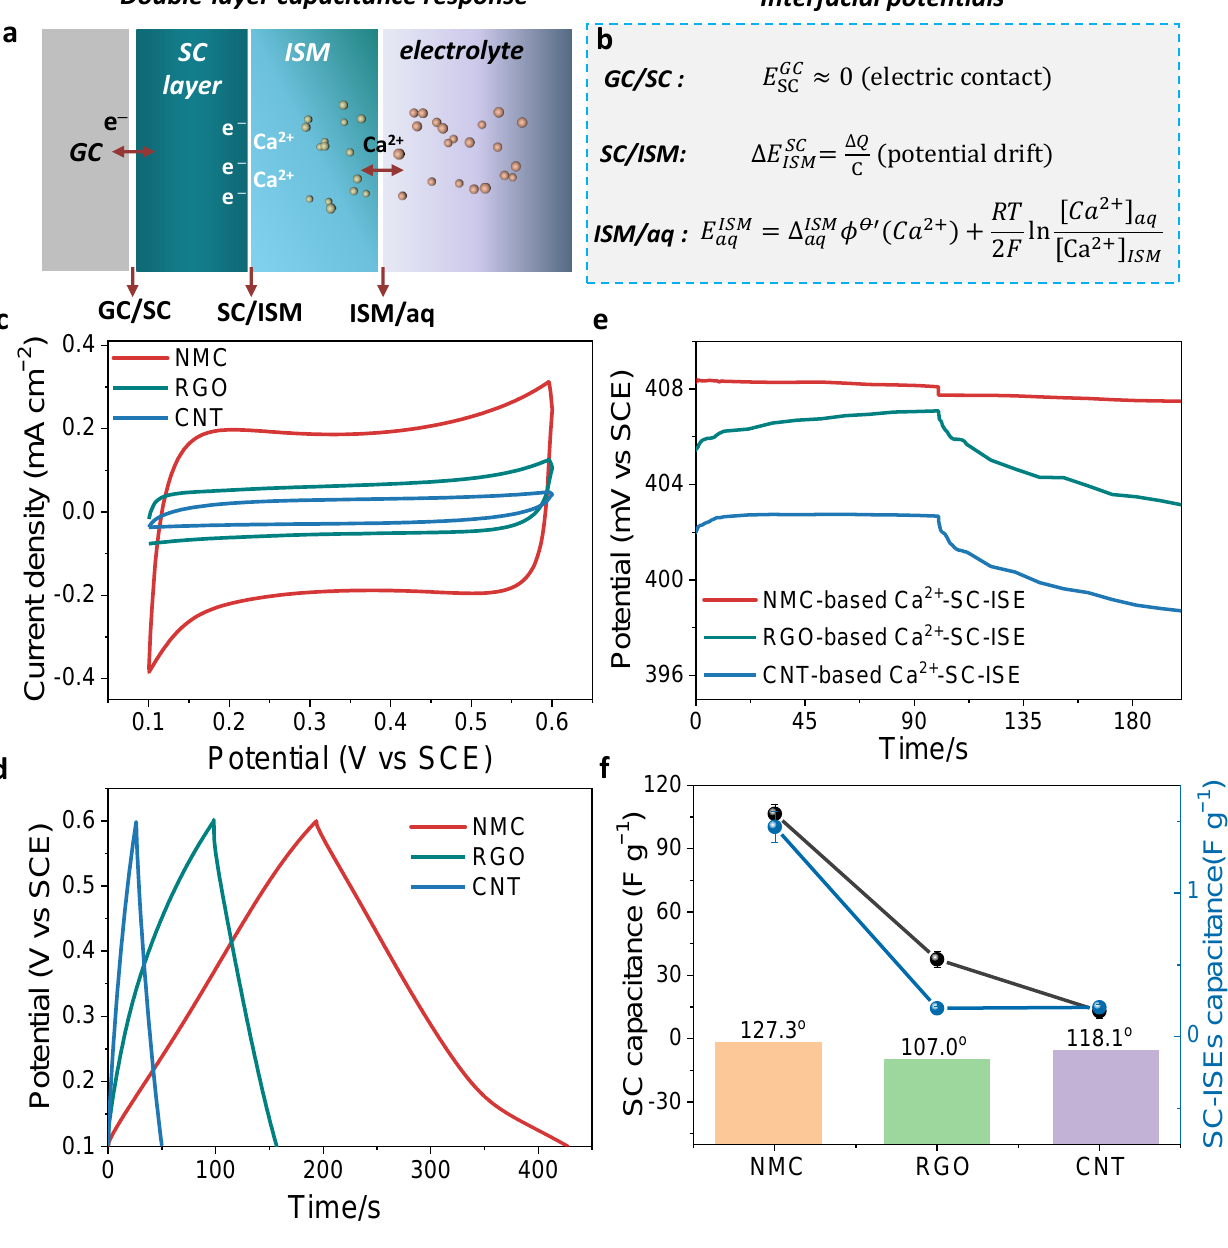
Figure 3. Capacitance evaluation. ( a ) Electric-double-layer (EDL) capacitance-based SC-ISEs which contain three phase boundaries including GC/SC, SC/ISM, and ISM/aq interfaces and ( b ) the corresponding phase interfacial potentials. ( c ) Cyclic voltammetry curves for SC materials (NMC, RGO, CNT) in 0.1 M CaCl 2 . ( d ) Corresponding charge – discharge tests of SC materials under a current density of 0.25 A g −1 . ( e ) Chronopotentiometry tests for the corresponding Ca 2+ -SC-ISEs based on NMC, RGO and CNT SC materials. ( f ) Summary of the capacitances of the SC materials and SC-ISEs and correlation with hydrophobicity (contact angles). The error bars for the SC-ISEs chronopotentiometry tests were calculated using three individual electrodes.